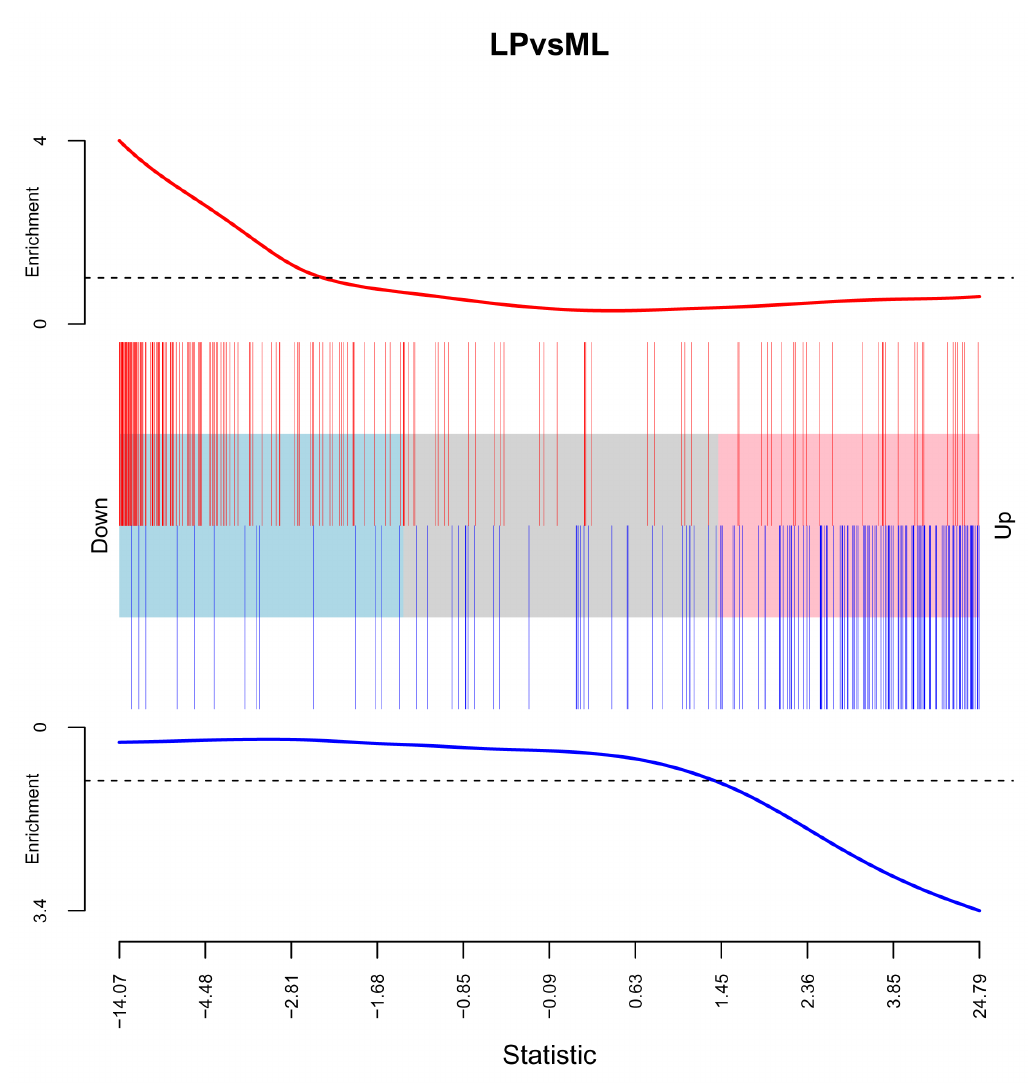
Figure 8. Barcode plot of LIM_MAMMARY_LUMINAL_MATURE_UP (red bars, top of plot) and LIM_MAMMARY_ LUMINAL_MATURE_DN (blue bars, bottom of plot) gene sets in the LP versus ML contrast. For each set, an enrichment line that shows the relative enrichment of the vertical bars in each part of the plot is displayed. The experiment of Lim et al. (2010) is very similar to the current one, with the same sorting strategy used to obtain the different cell populations, except that microarrays were used instead of RNA-seq to profile gene expression. Note that the inverse correlation (the up gene set is down and the down gene set is up) is a result of the way the contrast has been set up (LP versus ML) – if reversed, the directionality would